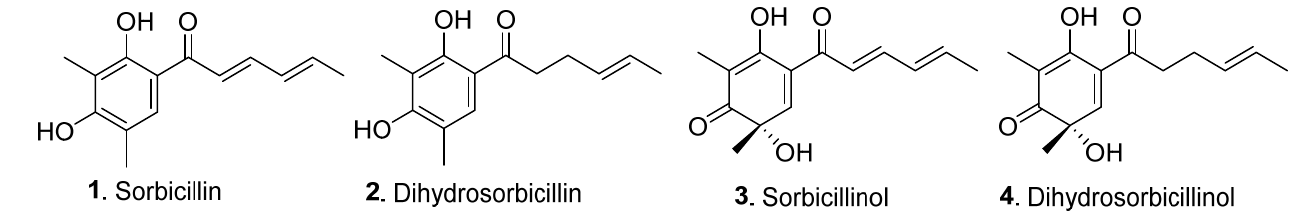
Figure 1. Basic structures of the monomeric sorbicillinoids ( 1 – 4 ).